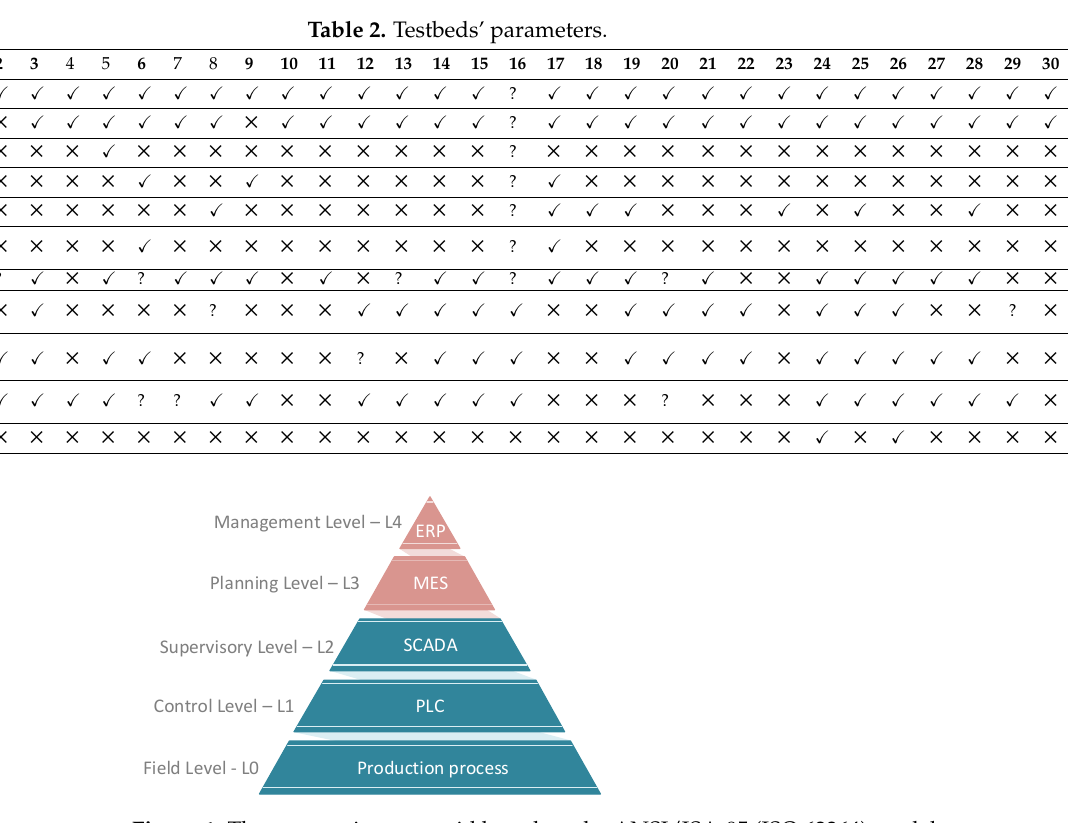
Figure 1. The automation pyramid based on the ANSI/ISA-95 (ISO 62264)